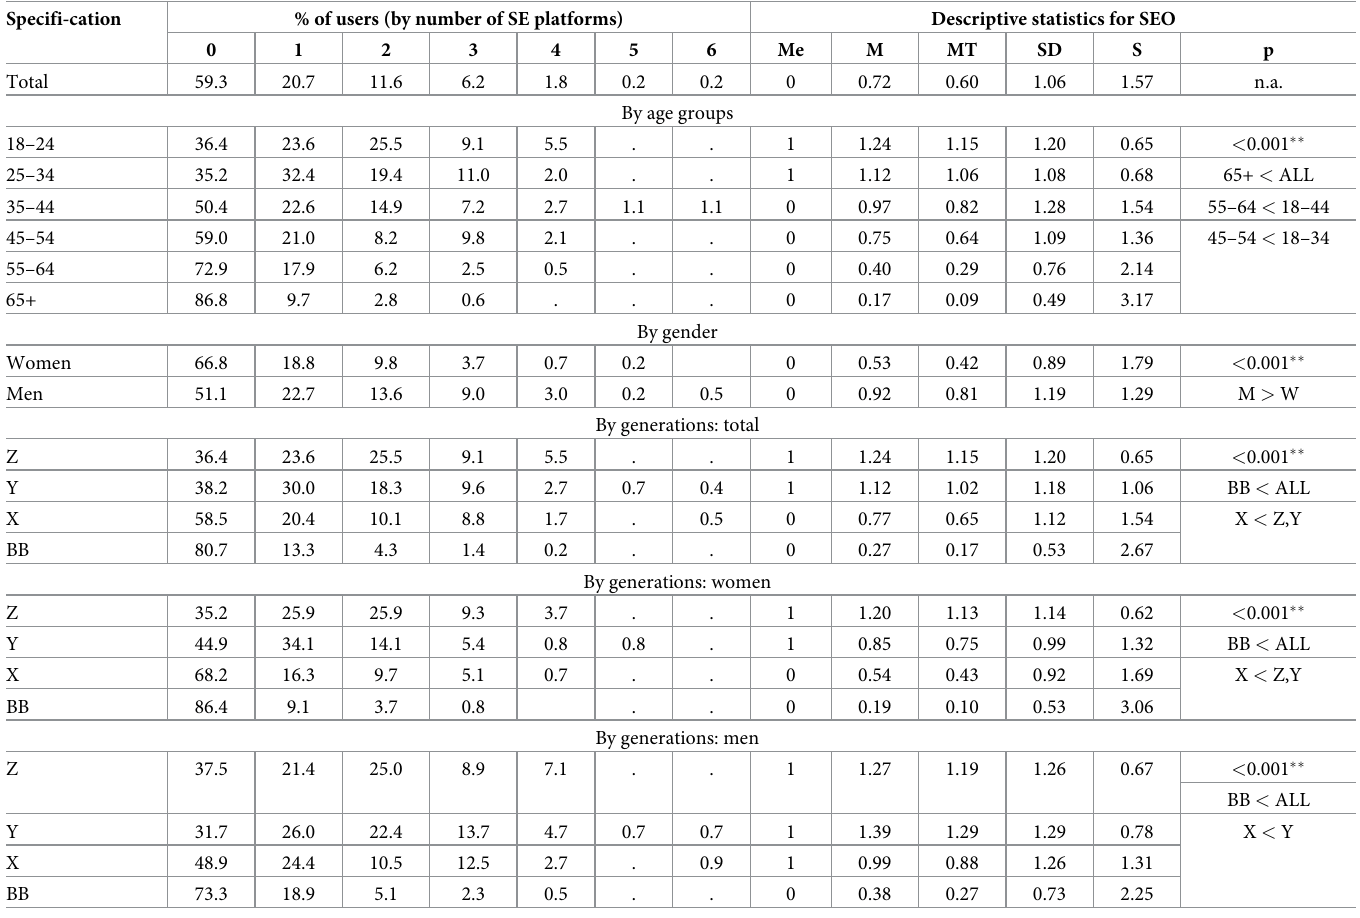
p—probability in Mann-Whitney test (for gender) or Kruskal-Wallis test (for age groups and generations); �� p < 0.01.—‘percentage of users’ in the sample equals